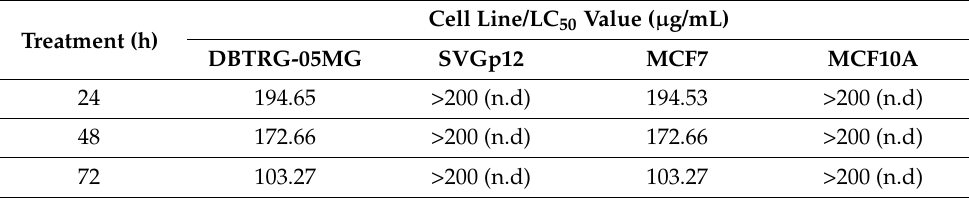
Figure 7. Cytotoxicity analysis of various concentrations of bioAgNPs against MCF-7 ( A ) and MCF-10A ( B ) cells within 24–72 h of treatment. The values presented are the means ± S.E. from three independent experiments. Statistical analysis was performed using Student’s t -test with a p < 0.05, b p < 0.01, and c p < 0.001 significantly different to the untreated cells. Table 2. The half-maximal lethal concentration (LC 50 ) values for DBTRG-05MG, SVGp12, MCF7, and MCF10A after treatment with various concentrations of bioAgNPs within 24–72 h. LC 50 values were estimated using non-linear